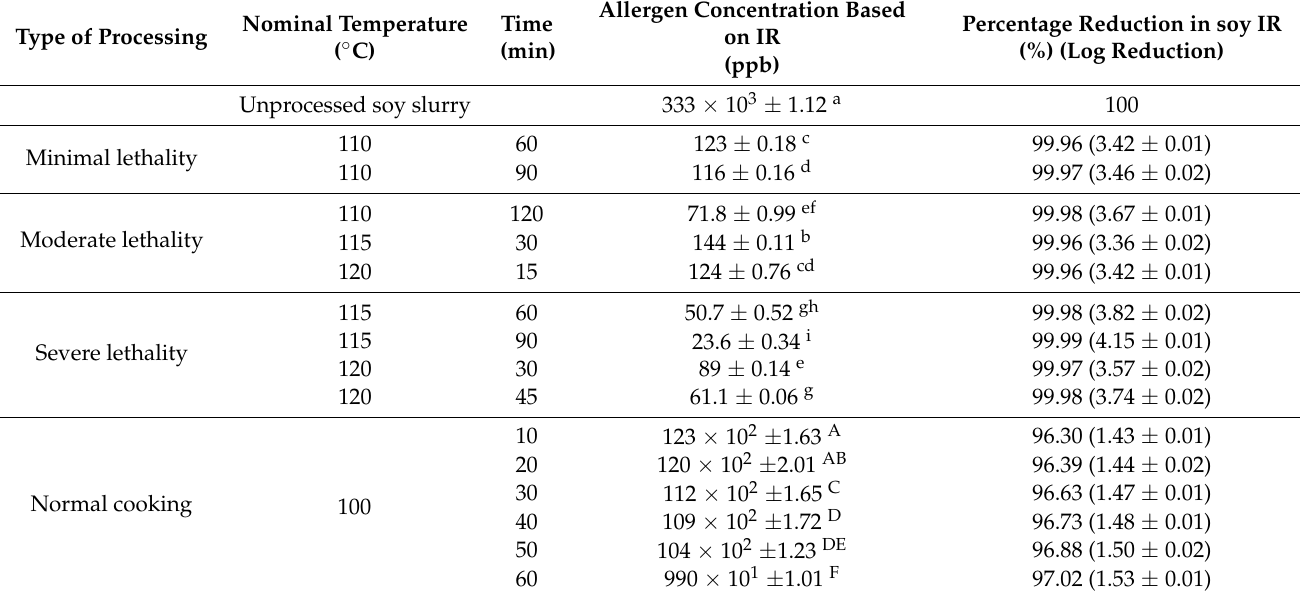
Table 2. IR of soy samples processed at different intensities and conventional thermal conditions, as determined via ELISA